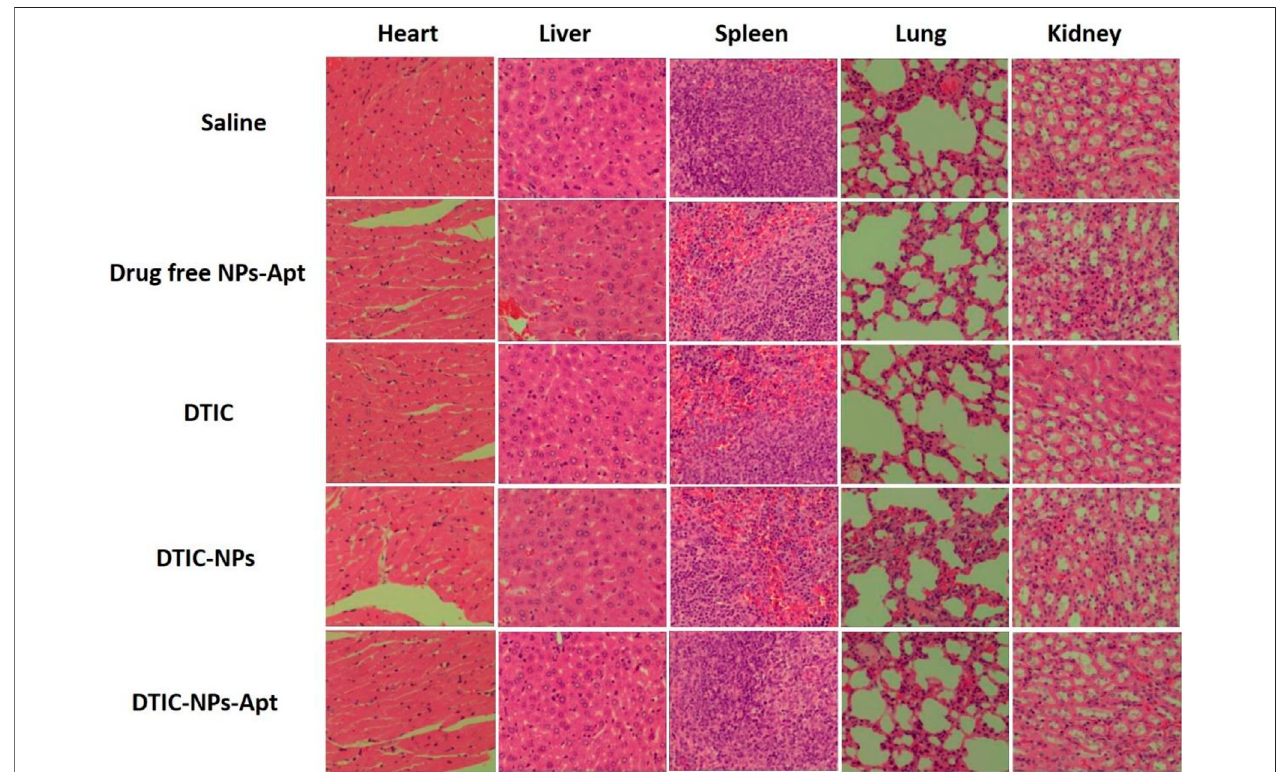
FIGURE8| Representativetissuesectionsofmicestainedwithhematoxylinandeosin(H&E)after16 daysoftreatment.Forallthegroups,noapparenttissueinjury was observed in the tissues of heart, liver, spleen, lung, and kidney.